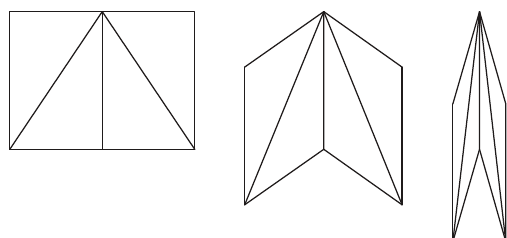
Figure 4: Parallelogram element of AM ring truss structure.